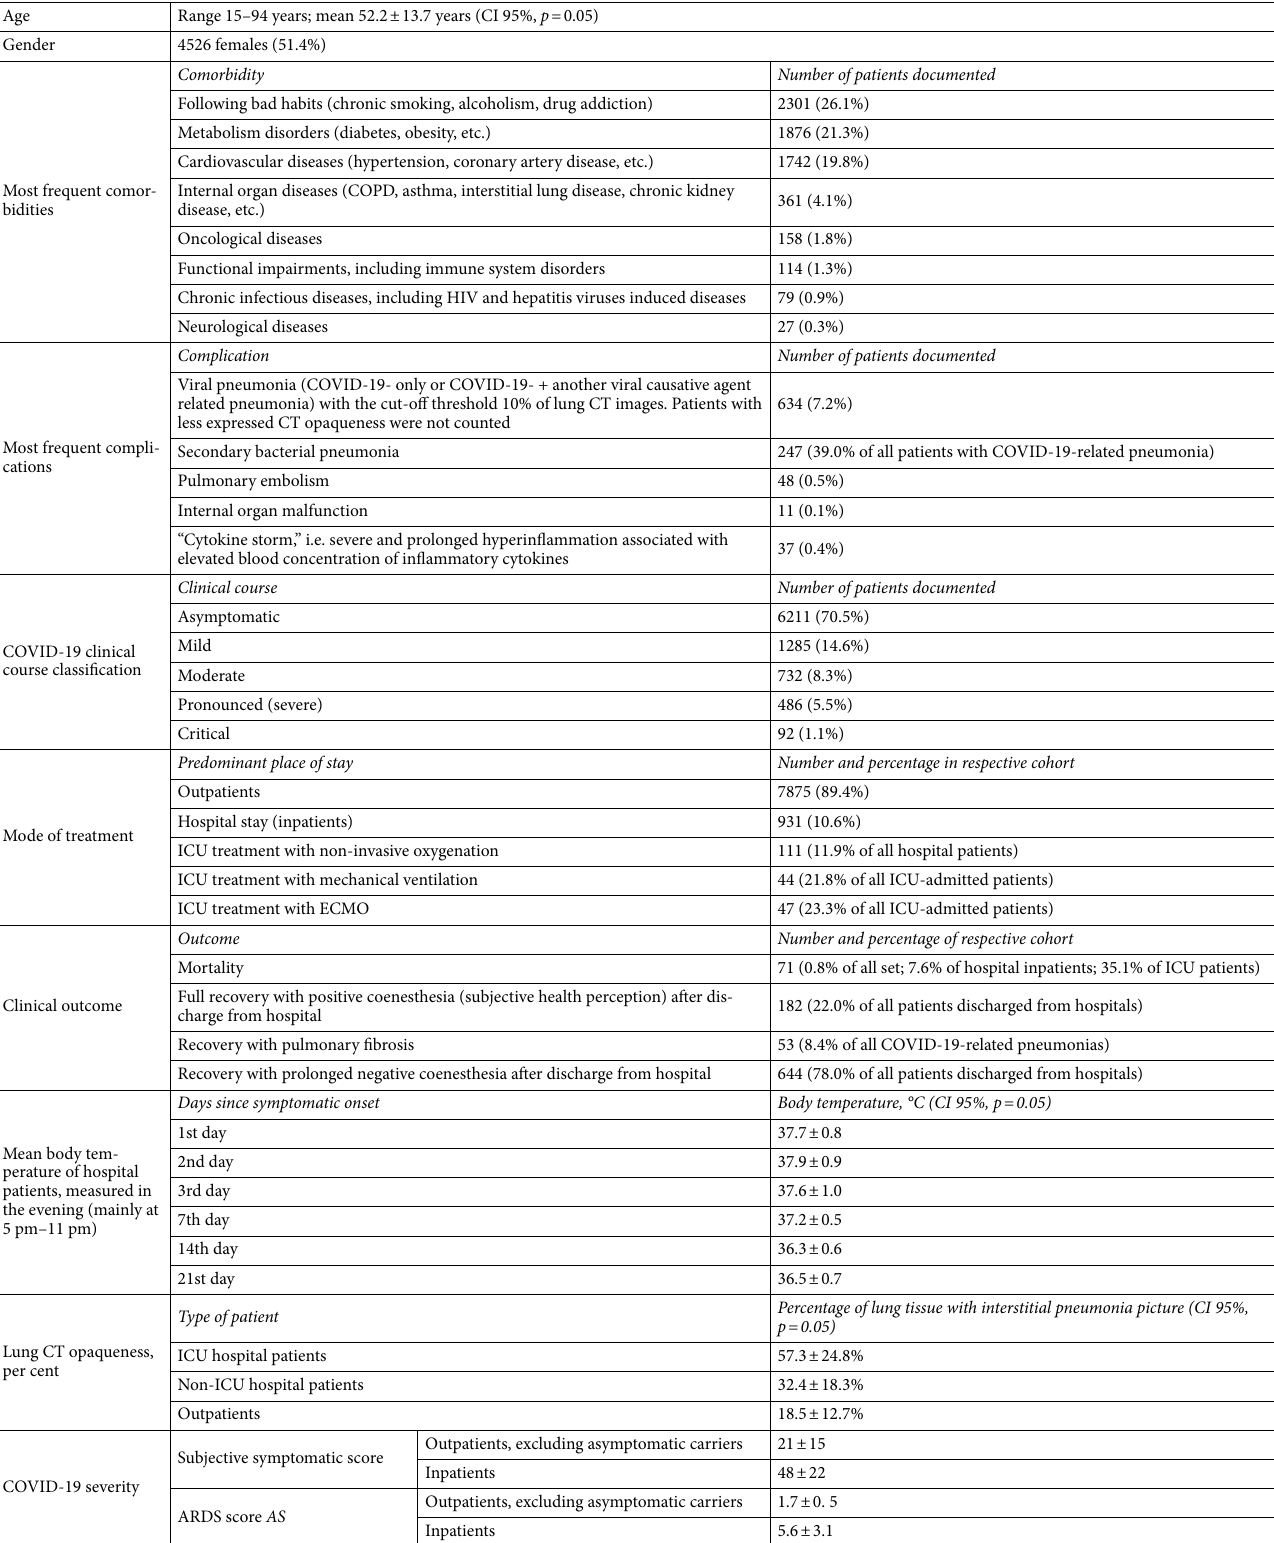
Table 2. Demographics of the patients studied and their main clinical